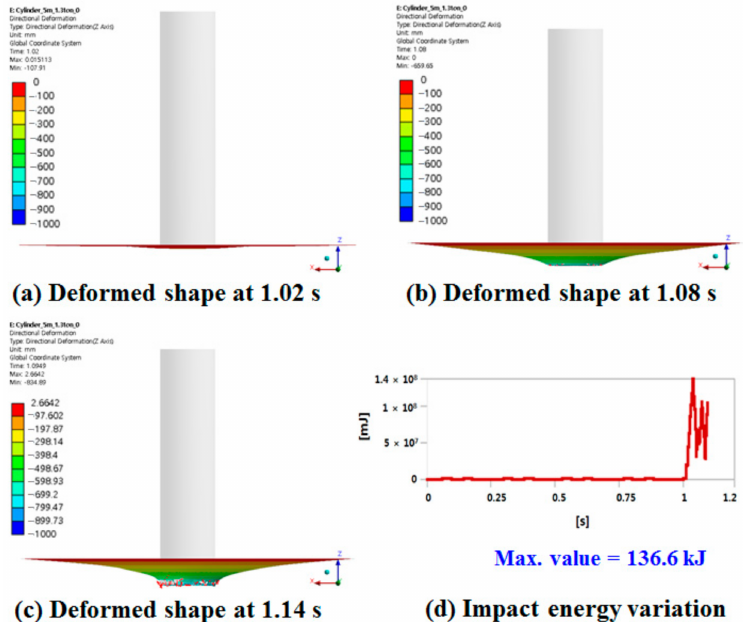
Figure 24. Simulation results (case 1, 0 ◦ ).